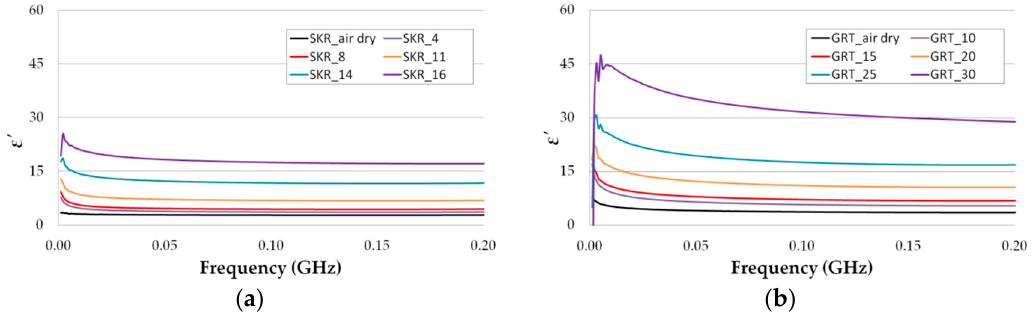
Figure 2. The real part of complex dielectric permittivity of SKR ( a ) GRT ( b ) soil samples with different water content over the frequency range from 1 MHz to 200 MHz. The name of sample consist of the type of soil and the mass of water per 100 g of dry soil in a given sample. Three VNA measurements from various soil samples were performed for each moisture content. The curves present average values with the maximum value of the standard error ±